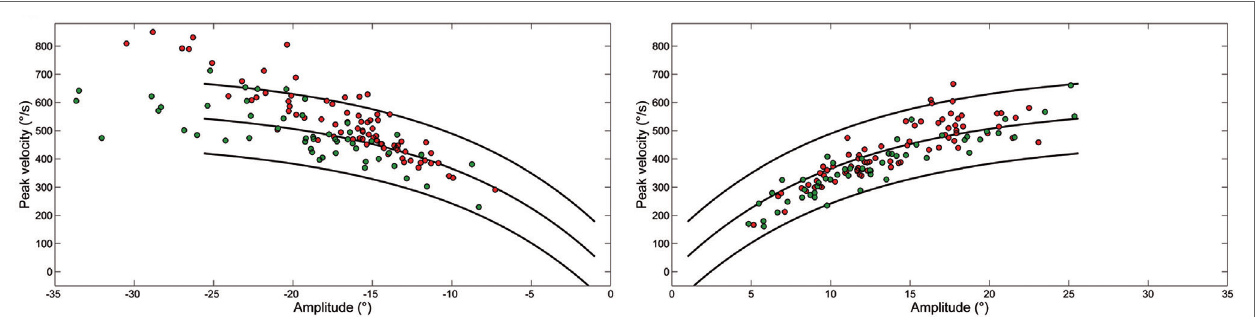
FigUre 3 | Plot of main sequence relationships between peak velocity and amplitude of saccades from Patient 1 (green) and Patient 2 (red) as data points. Curves show the main sequence relationship and 5 and 95% prediction intervals for healthy subjects. Plot of peak velocity versus amplitude of leftward (LW) and rightward saccades from each ataxia-telangiectasia-like disorder patient. Larger LW saccades made by Patient 2 often exceeded the 95% confidence interval for healthy